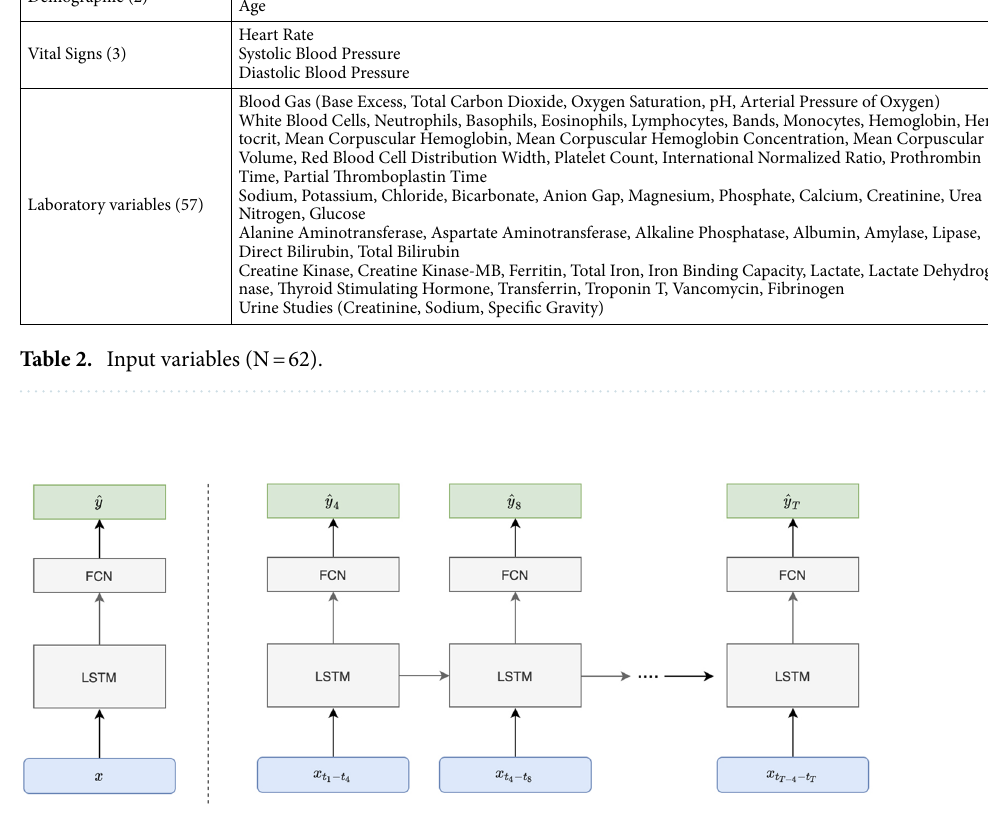
Figure 2. Long-Short Term Memory (LSTM) Network Model Overview. Electronic Health Record data (vitals, laboratory values) is fed into the model, passed through the layers, transformed, and gives a probability of the outcome (transfusion of packed red blood cells). At the beginning of each 4-h interval the LSTM Network can generate a probability of needing transfusion. T represents the time in hours, X represents input data (vitals, laboratory values), Y represents the probability of needing transfusion, and FCN is a fully convolutional network that processes the information from the previous time period to generate the